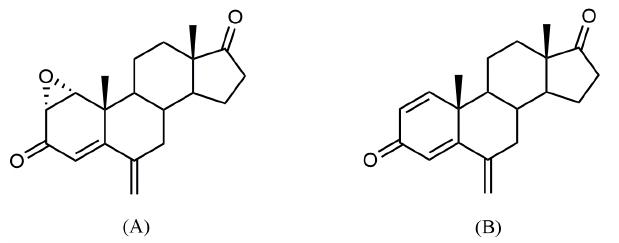
Figure 1. Chemical structures of 1 α ,2 α‐ epoxy ‐ 6 ‐ methylenandrost ‐ 4 ‐ ene ‐ 3,17 ‐ dione, also known as Oxymestane ‐ D1 ( Oxy ) ( A ) and its parent compound exemestane (Exe) ( B ).